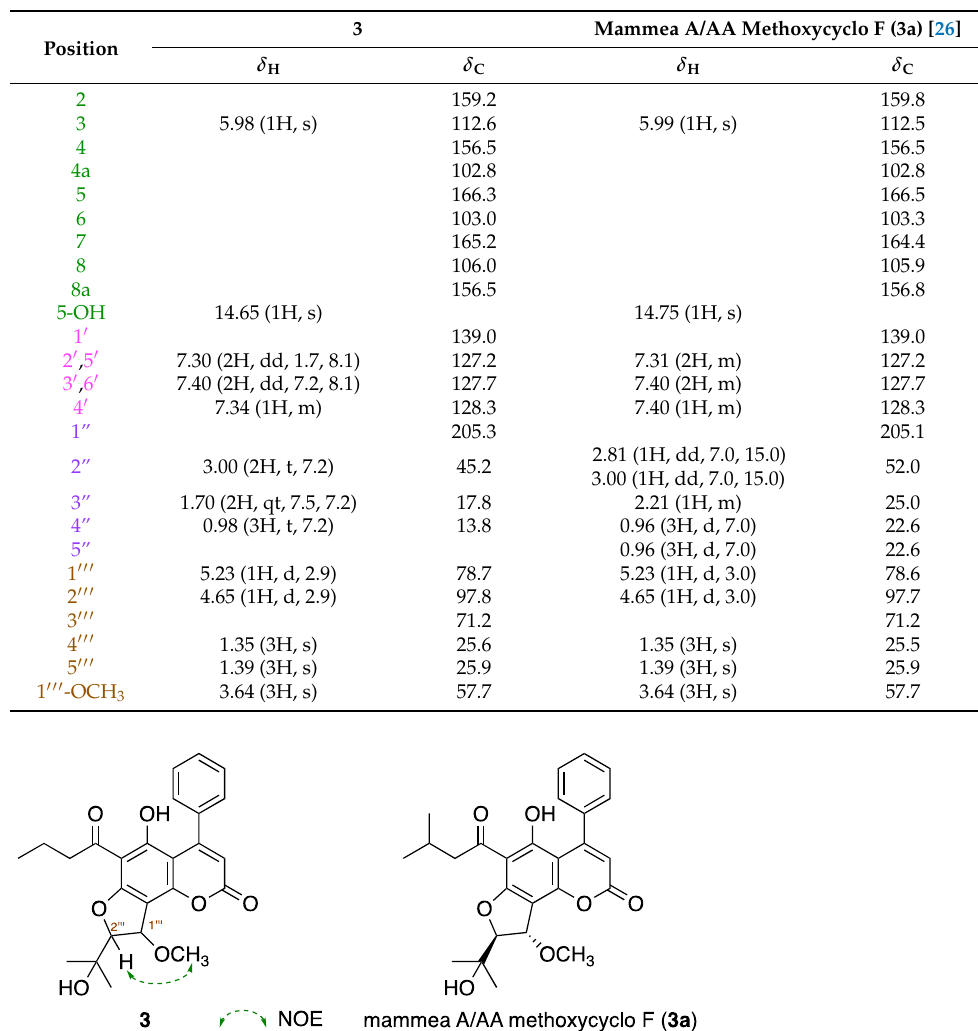
Table 3. 1 H and 13 C NMR spectroscopic data (500 mHz, CDCl 3 ) of mammeasin M ( 3 ) and mammea A/AA methoxycyclo F ( 3a ).